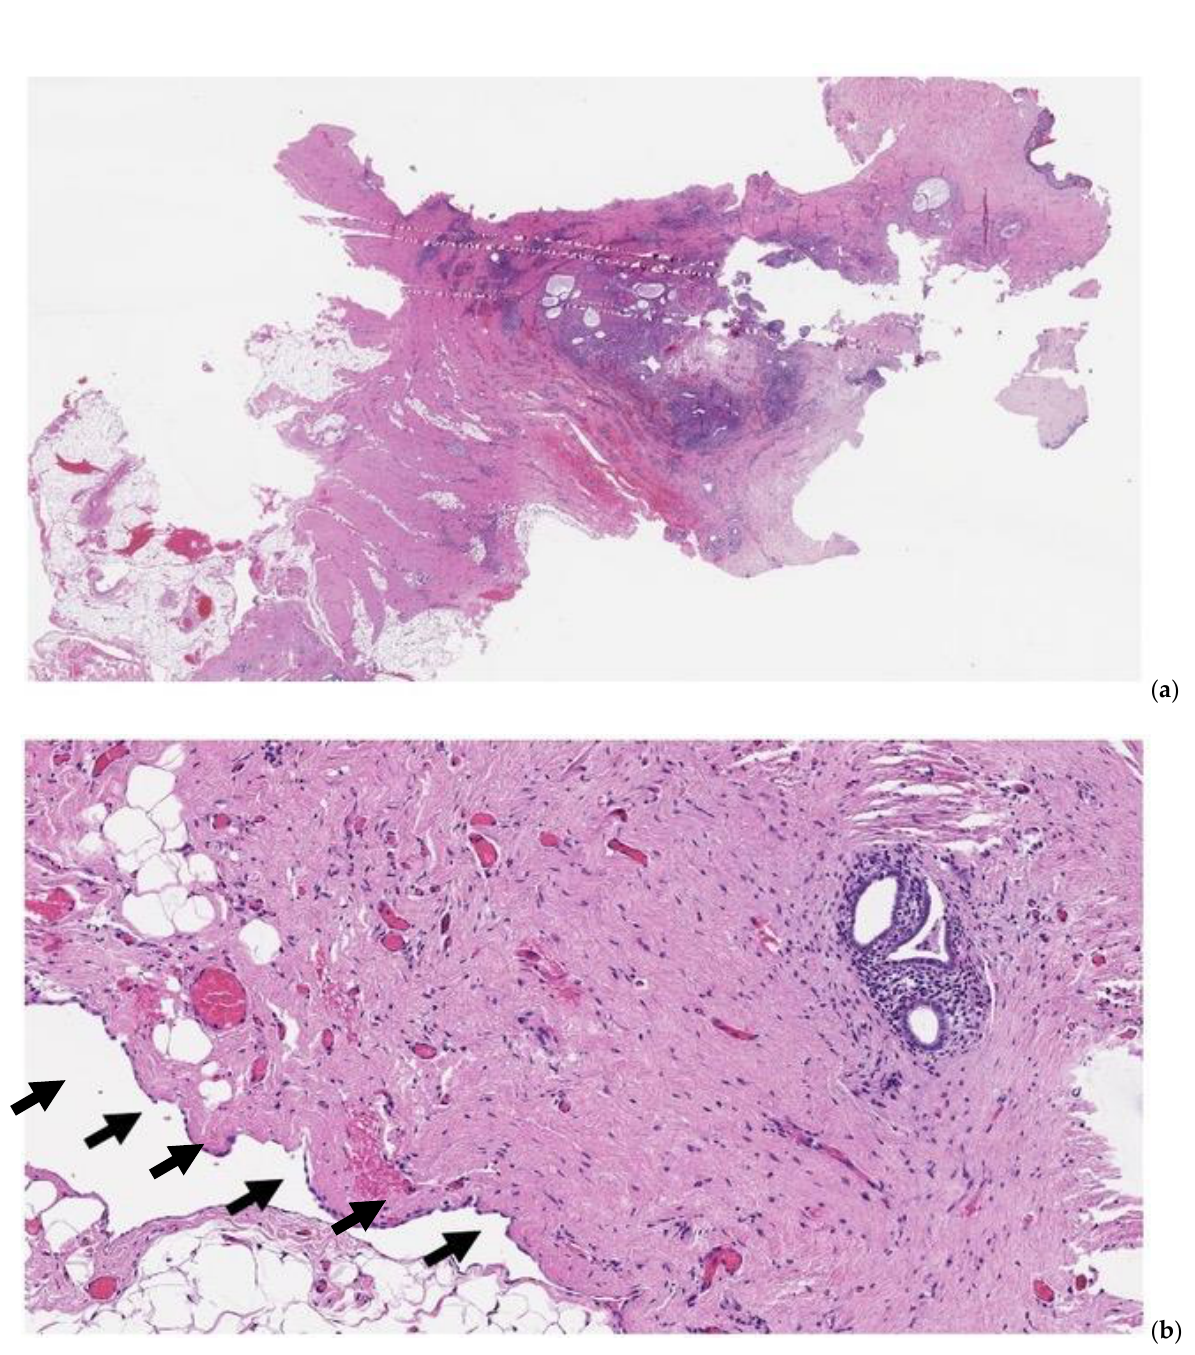
Figure 3. The umbilical peduncle is dissected down to the parietal peritoneum, which is included in the resected tissue ( a ). Anatomical specimen of en-bloc resection of umbilical endometriosis from the skin aspect to the parietal peritoneum ( b ).